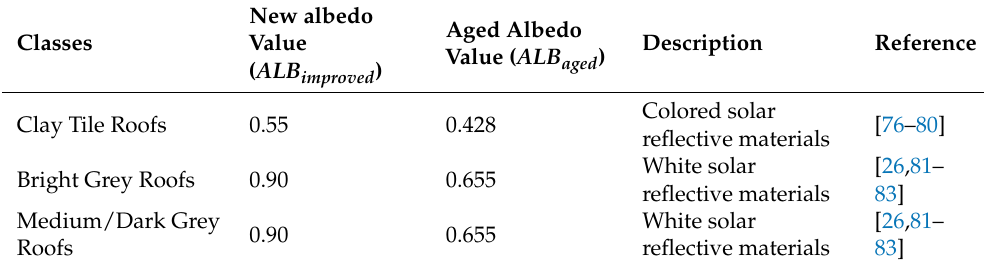
Table 7. Improved and aged albedo value of solar reflective materials retrieved from scientific literature.